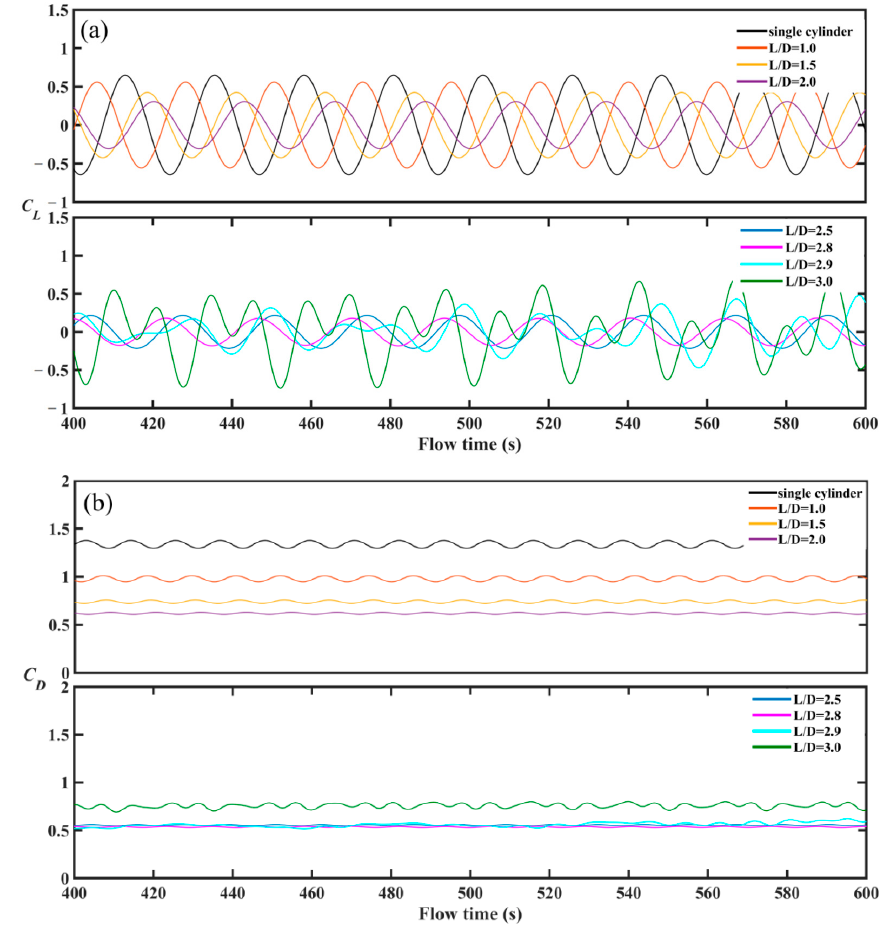
Figure 2. Variation of the force coefficient acting on the main cylinder with spacing ratio at different l (cid:2933) D⁄ , ( a ) amplitude of lift coefficient; ( b ) mean drag coefficient. The typical time histories of the lift and drag coefficient with the spacing ratio of L/D at 𝑙 (cid:3050) D⁄ = 0.40 are presented in Figure 3. Figure 3 also includes the time history of the lift and drag coefficients for a single cylinder. Figure 3a, b depicts regular sinusoidal fluctuations of the lift and drag coefficient for L/D ≤ 2.8. When L/D > 2.8, the lift and drag coefficients show irregular oscillation, which is an indication of the wake impingement mode.